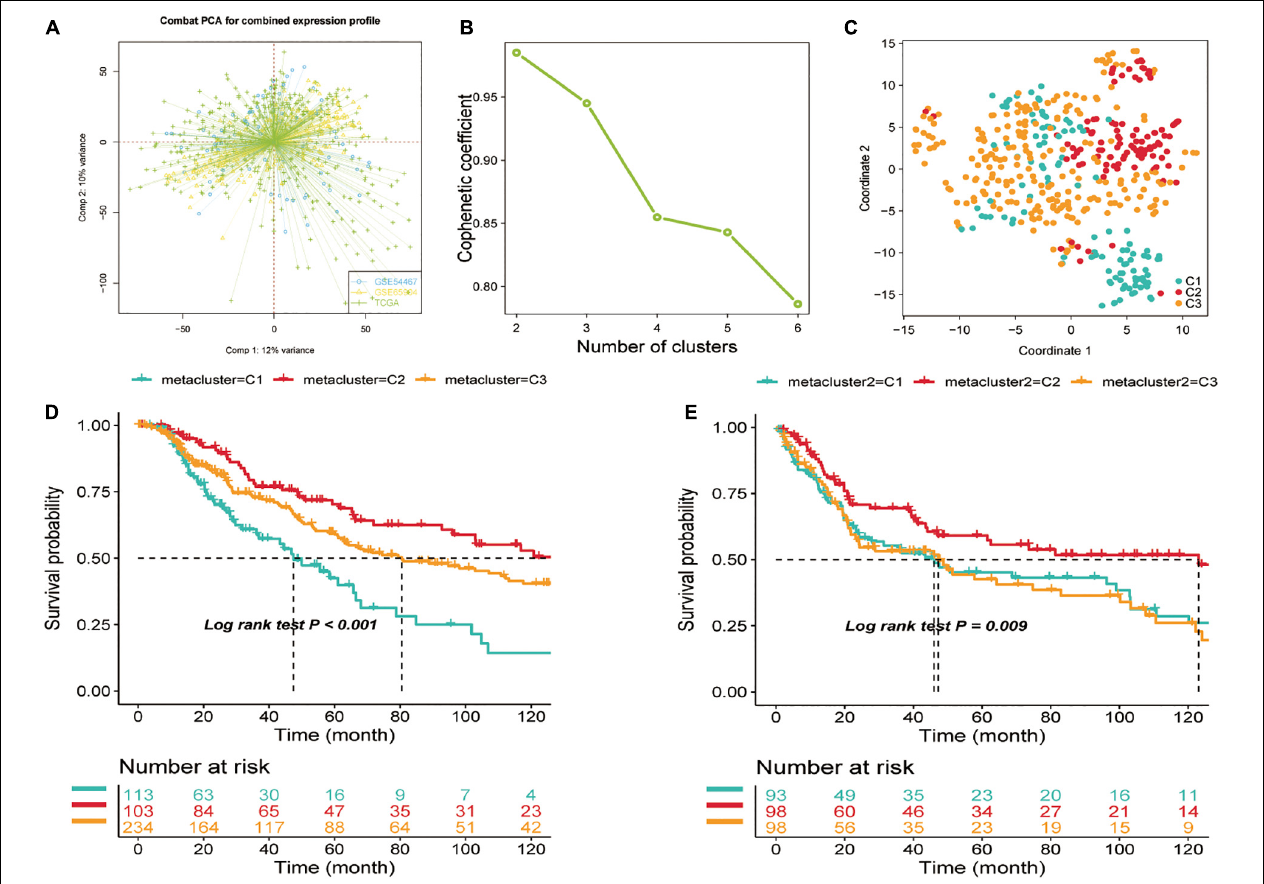
FIGURE 1 | Identification of skin cutaneous melanoma (SKCM) subtypes using non-negative matrix factorization (NMF) consensus clustering in the metadata set. (A) Visualization of principal component analysis of combined expression profiles of three cohort data sets. (B) Phenotype correlation coefficients for NMF clustering of 816 metabolism-related genes at k = 2–5. (C) t-SNE analysis rendered in support of classification into three SKCM subtypes. (D) Overall survival analysis of three subtypes (C1, C2, and C3) in two independent cohorts—test set (TCGA-SKCM) and (E) Validation set (GSE65904, GSE54467). Statistical significance of differences was determined using the log-rank